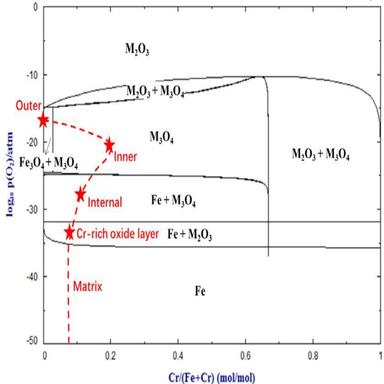
Calculated oxygen partial pressure versus composition diagram of the Fe-Cr-O ternary system at 600 °C using the FactSageEdu program . M represents Fe+Cr.